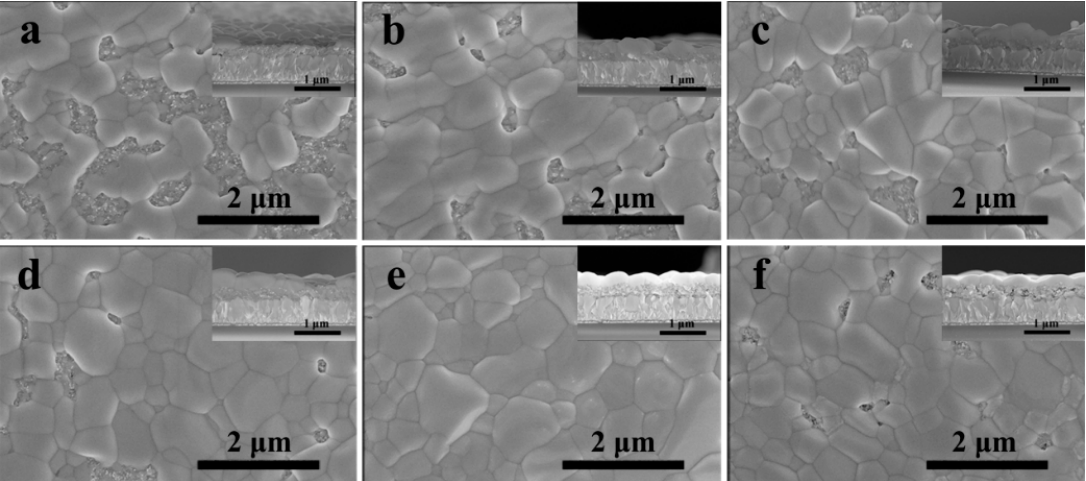
Figure 3. Top-view and cross-sectional (insets) SEM images of CsPbBr 3 films by introducing different concentrations of InBr 3 : ( a ) 0.00 M; ( b ) 0.03 M; ( c ) 0.09 M; ( d ) 0.15 M; ( e ) 0.21 M; ( f ) 0.27 M.